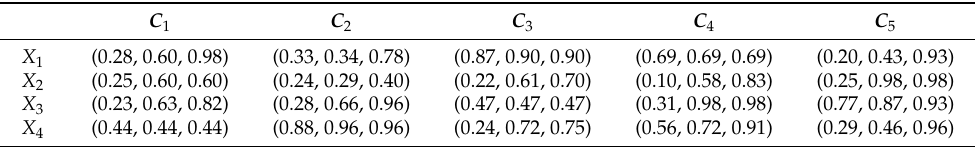
Table 3. Standardized Hesitant Fuzzy Decision